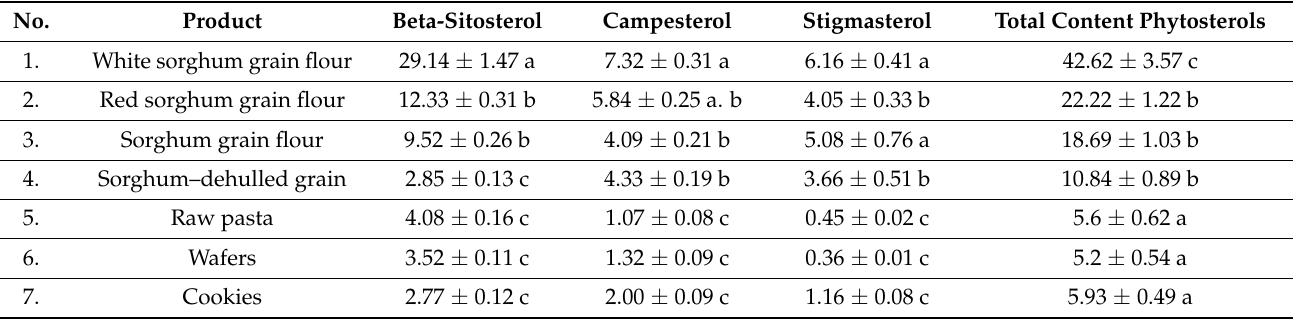
Figure 2. Structural formulas of selected plant sterols. Table 6. Content of selected phytosterols (mg/kg) in food products.